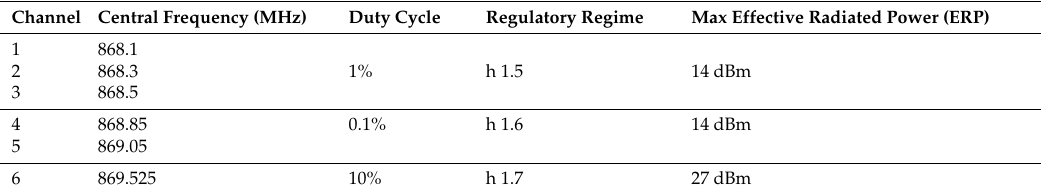
Table 1. LoRaWAN default channels and duty cycle